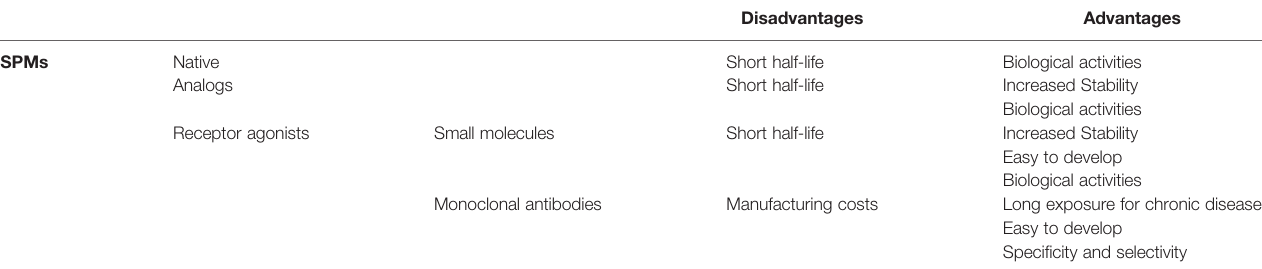
TABLE 5 | Therapeutic approaches for the development and use of SPM mimetics in cancer